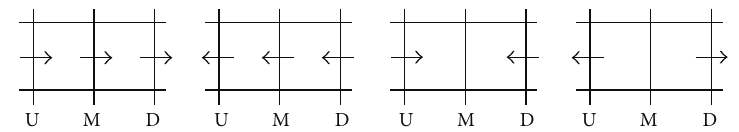
Figure 1: The flow direction at a single river channel changes with ebb and flood current in the tidal river. And the direction can be classified by four types (from the left to the right): (1) downflow, (2) upflow, (3) faced-flow, and (4)